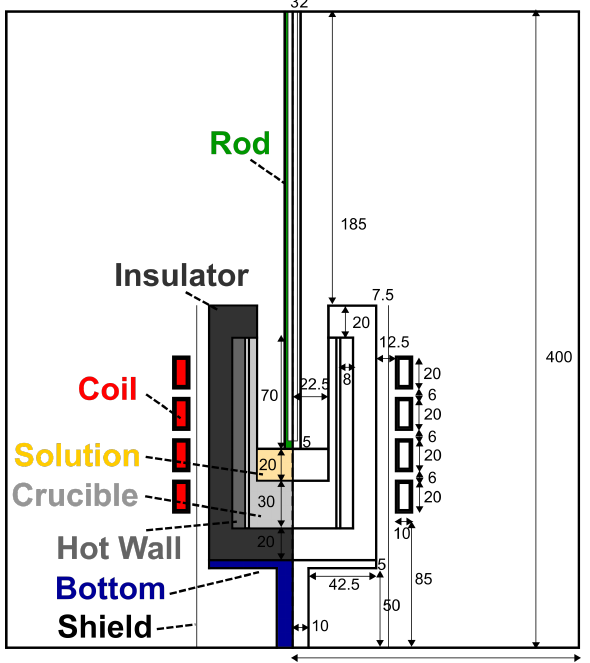
Figure 1. Schematic view of the computational domain used for the TSSG